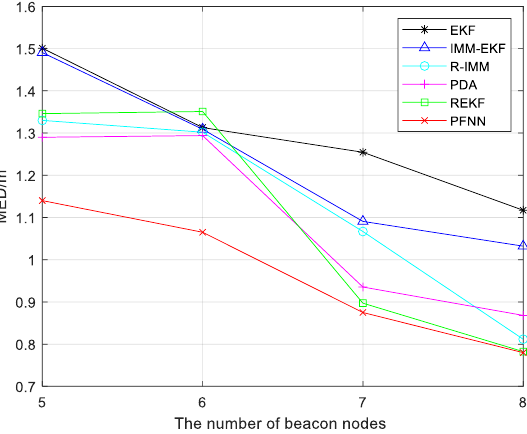
Figure 14. MED with the number of beacon nodes varying from 5 to